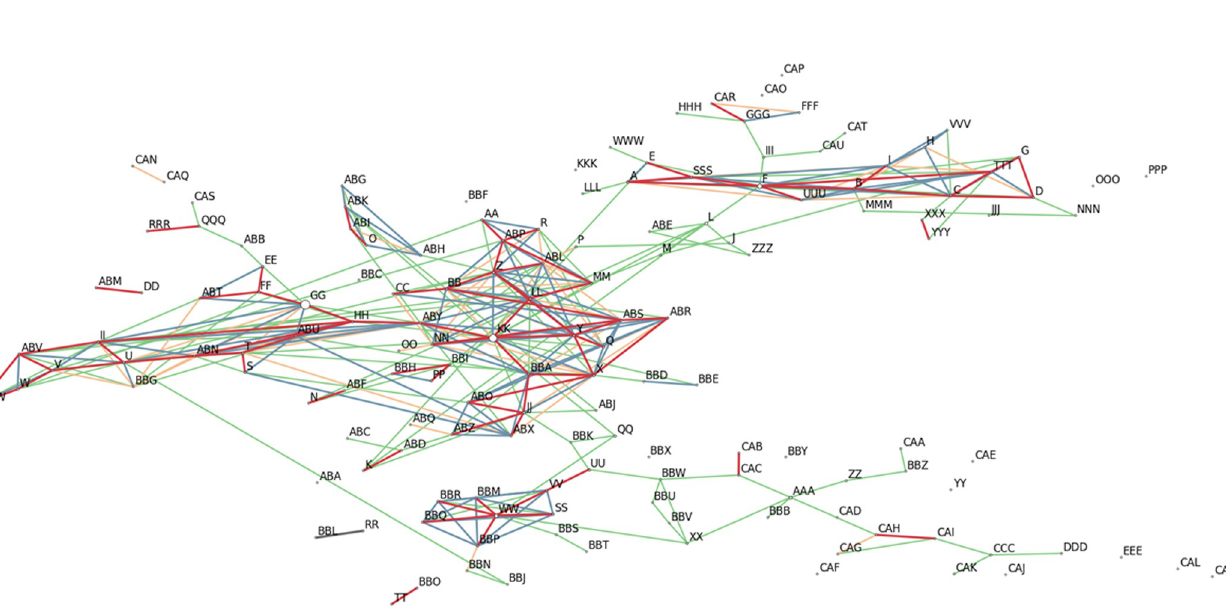
Fig 8. Haplotype network based on six cpSSR markers genotyped in three data sets F, C and G. Size of the nodes reflects number of individuals assigned to the respective haplotype. The percolation threshold is 2.67 Red lines present the closest links, blue to green, yellow and no colour lines indicate links following decreasing relationship between